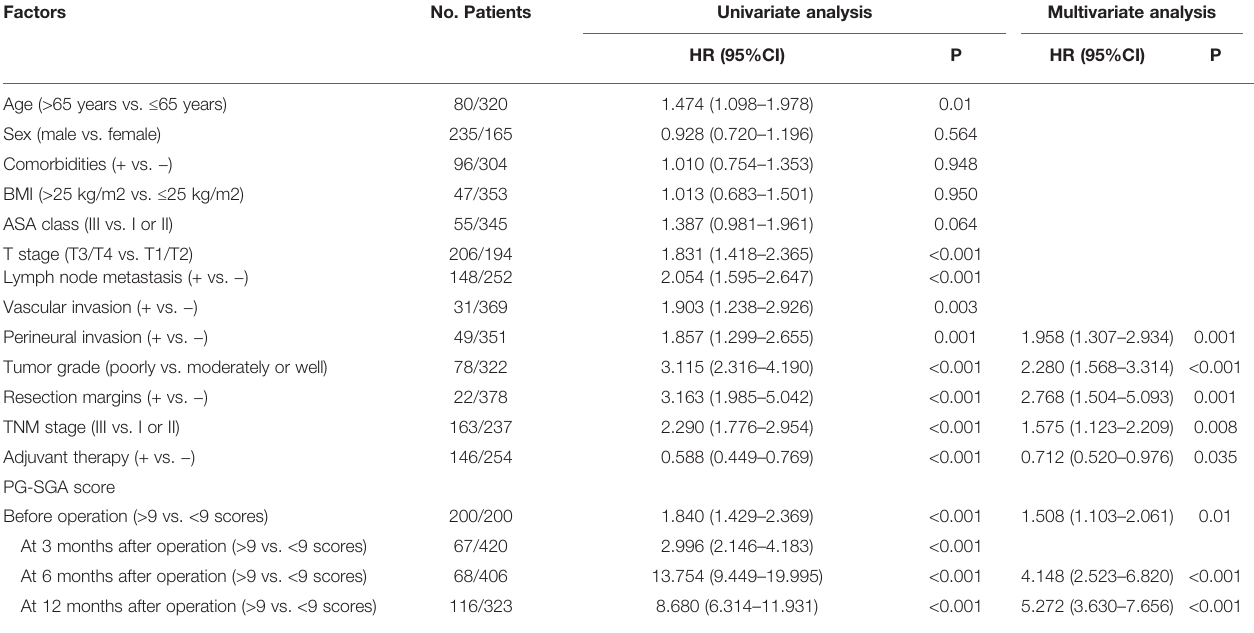
TABLE 4 | Univariate and multivariate Cox proportional hazard regression analysis of prognostic factors for OS in patients who underwent pancreatoduodenectomy for ampullary carcinoma after PSM.